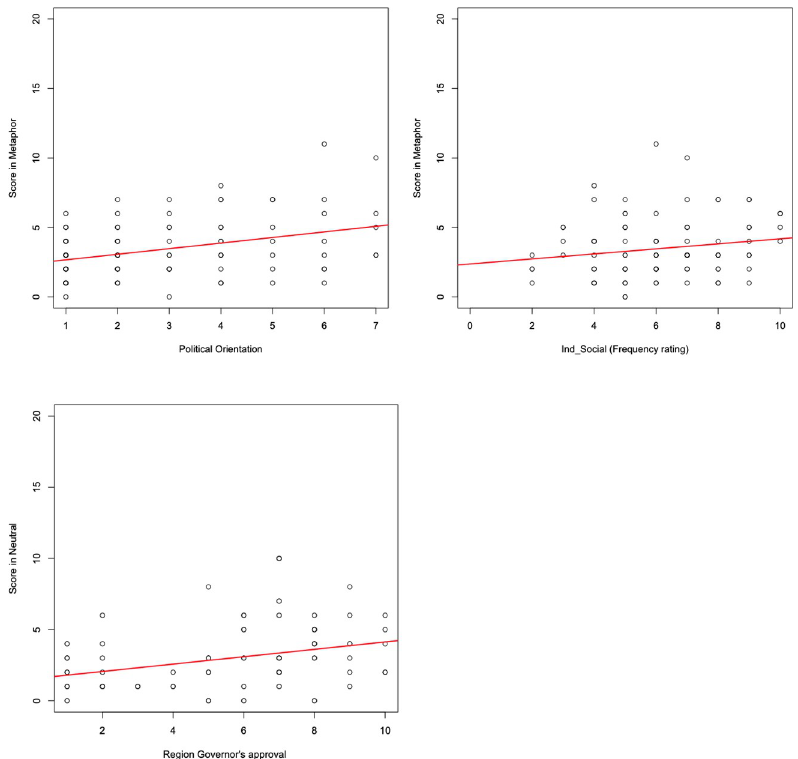
Fig 2. Predictors of participants’ score in the metaphor task. Top: Correlations between participants’ score in the metaphor condition and their political orientation (left panel) and the frequency rating (composite score) for independent information channels and social networks (right panel). Bottom: Correlation between participants’ score in the neutral condition and their Region governor’s approval.